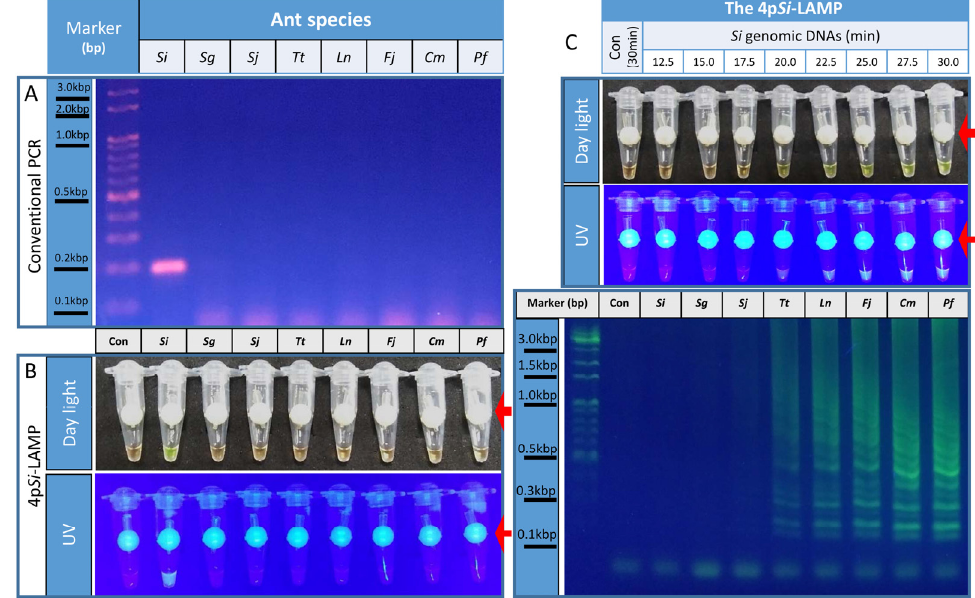
Figure 1. Si 11977 was a Si -specific biomarker. ( A ) The Si 11977-F3 and Si 11977-B3 primer pair specifically amplified a DNA fragment from Si genomic DNA. A strong 196-bp band was detected from Si but not from the other seven ants. ( B ) When the 4p Si -LAMP assays were performed, strong fluorescence signals under daylight or UV light were only detected from the tube containing Si genomic DNA. ( C ) To determine the optimum incubation period for the 4p Si -LAMP assay, LAMP mixtures containing 5 ng of Si genomic DNA were incubated at 65 ◦ C for 12.5 to 30 min at 2.5-min intervals. Fluorescence signals under daylight or UV illumination were detected after 20 min. When those reactions were separated by a 1.5% agarose gel, ladder-shaped DNA bands were detected from tubes incubated for longer than 20 min. Red arrows indicate the fluorescence dye-delivering devices, which are white round beads with a short and thin tube in the